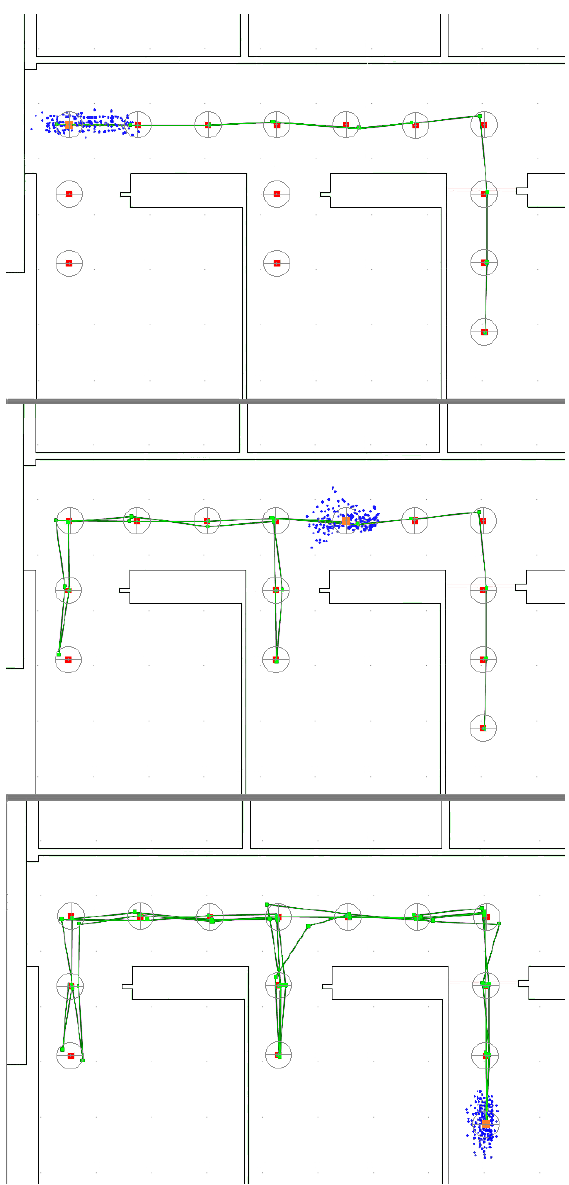
Figure 13. IMU data error representation using the particle filter, the model-based navigation and ultrasonic range measurements. Cloud of particles after 9 steps ( top ), 21 steps ( middle ), 52 steps ( bottom ). The true user position is marked by the center of the circle. The weighted average of the particles positions was chosen as the user position